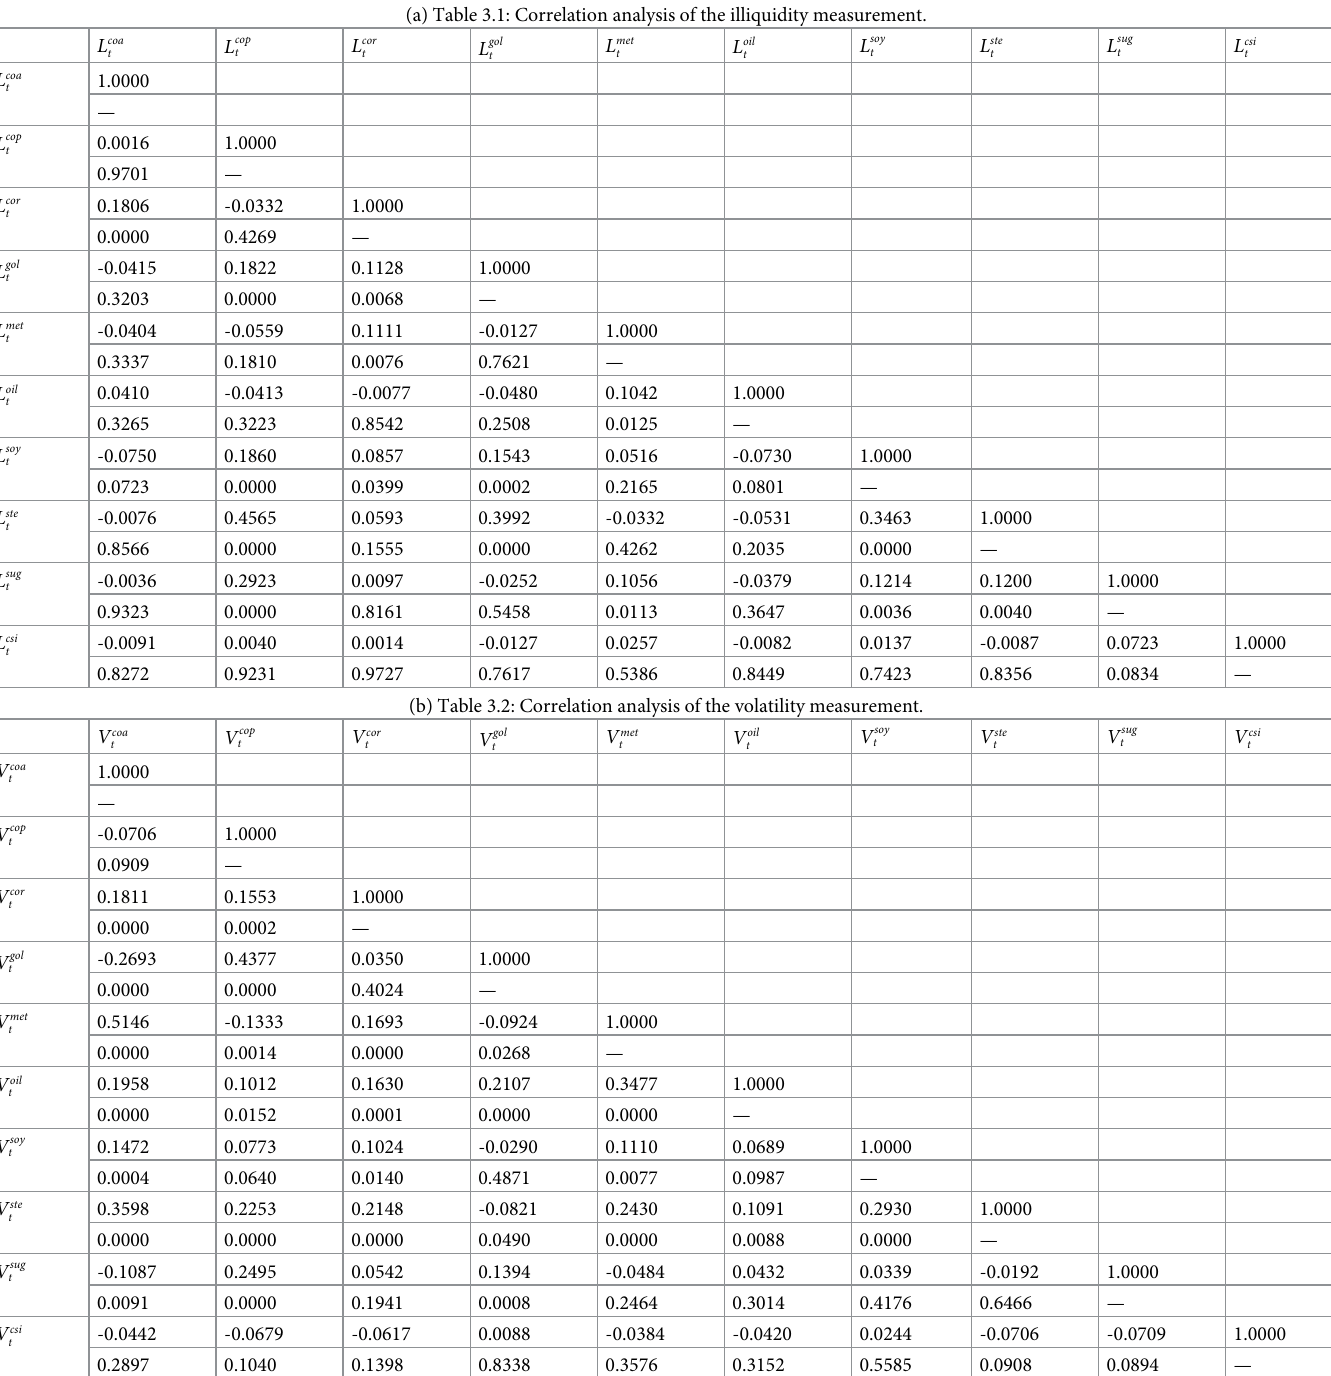
Table 3. The correlation matrix. The table presents the correlation among illiquidity series and volatility series for all financial markets. The sample runs from January 1, 2010 to March 22, 2021. (a) Table 3.1: Correlation analysis of the illiquidity measurement.